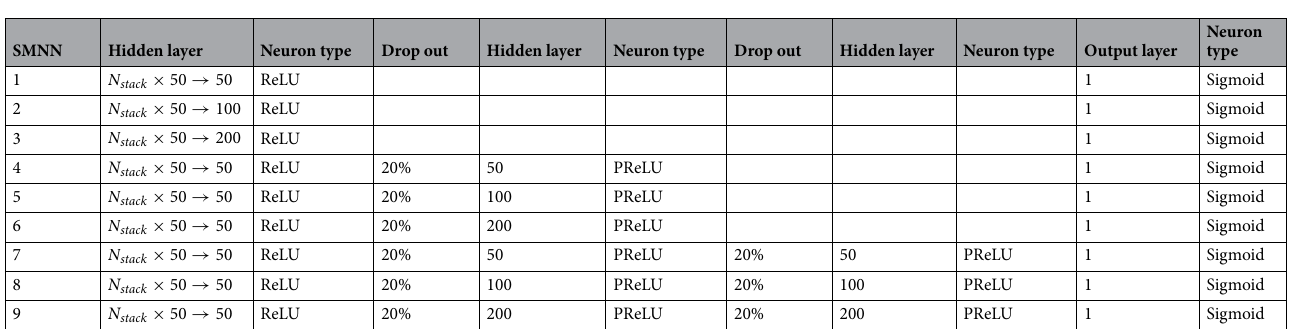
Table 3. Description of SMNN architectures. Numbers correspond to the number of neurons in each layer. For example, SMNN 1 consists of one hidden linear layer with 50 ReLU neurons and a linear output layer with one sigmoid neuron. N stack × 50 denotes dimension of the input to the first hidden